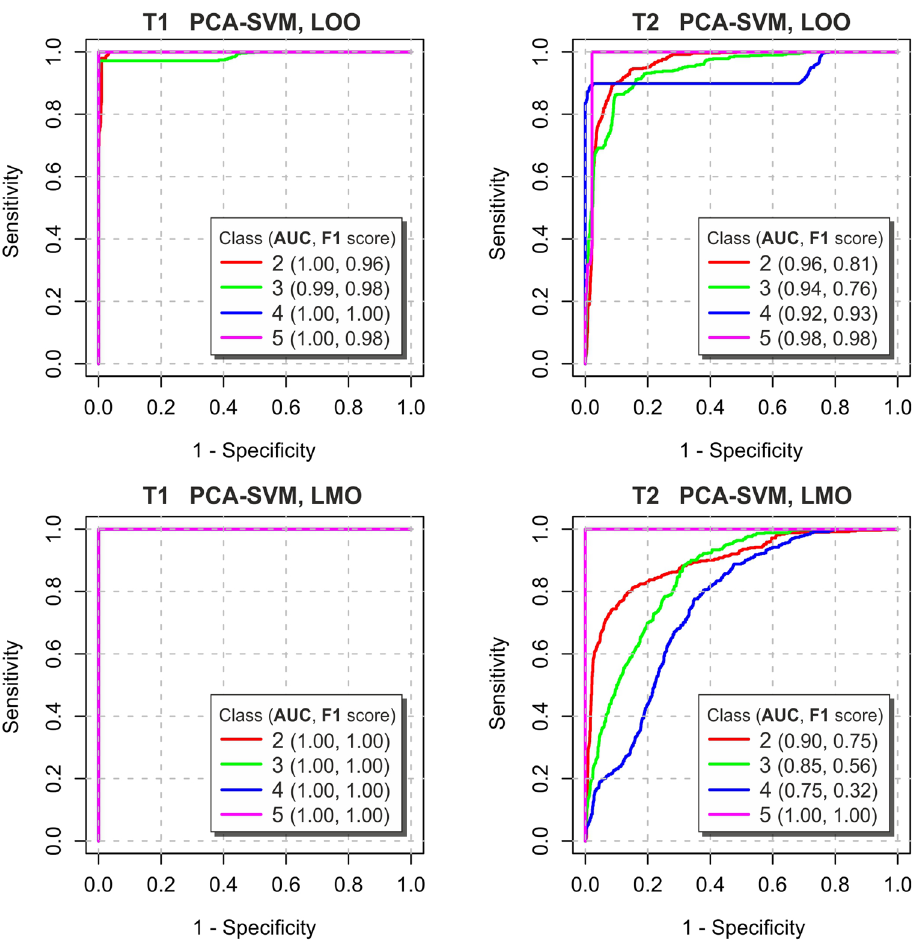
Figure 7. ROC curves type OvR for each pilling grade class obtained from the nonlinear SVM classifier of the 5 PCA components, after the abrasion tests T1 and T2. Optimal cut-points on the curves are given as Sensitivity and Specificity in supplemental Table S6. AUC and F 1 values are presented in the legend.